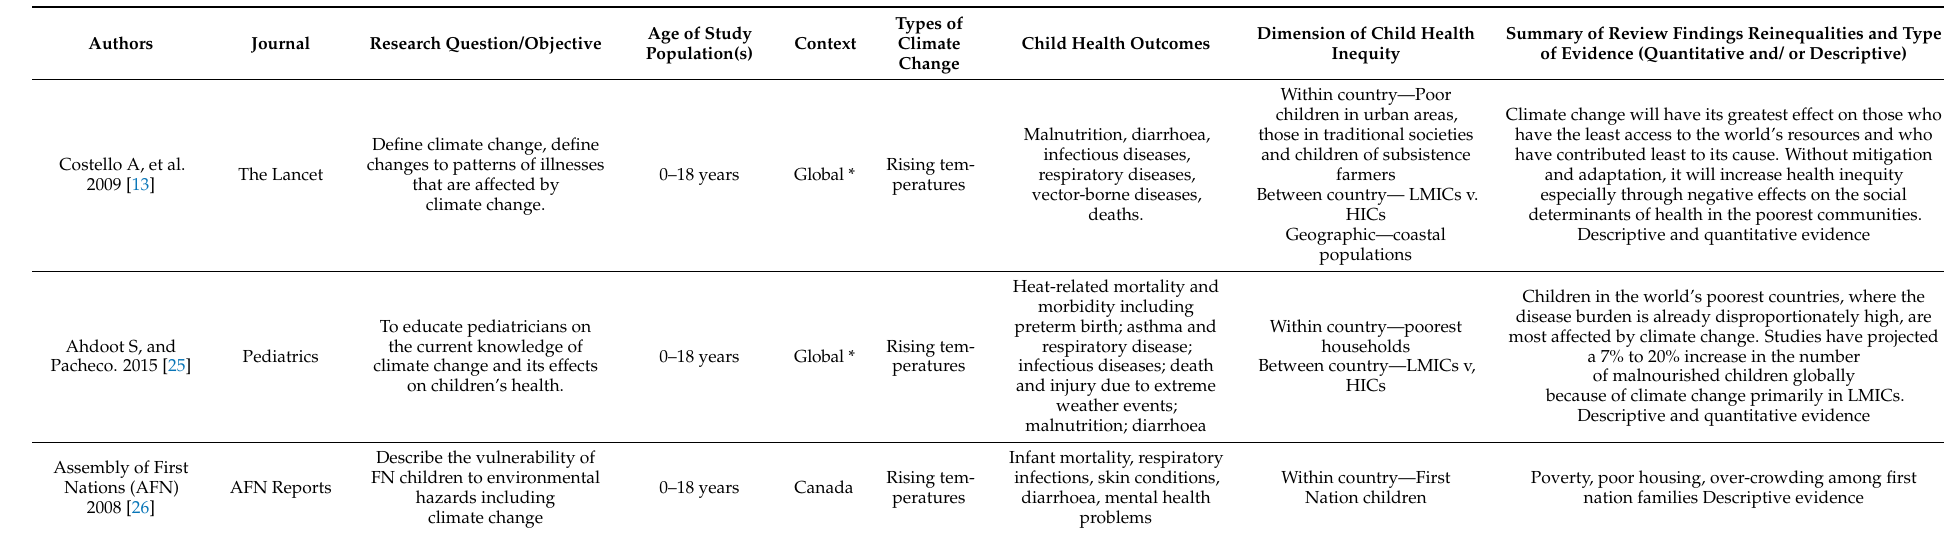
Table 3. Technical and commissioned reports.